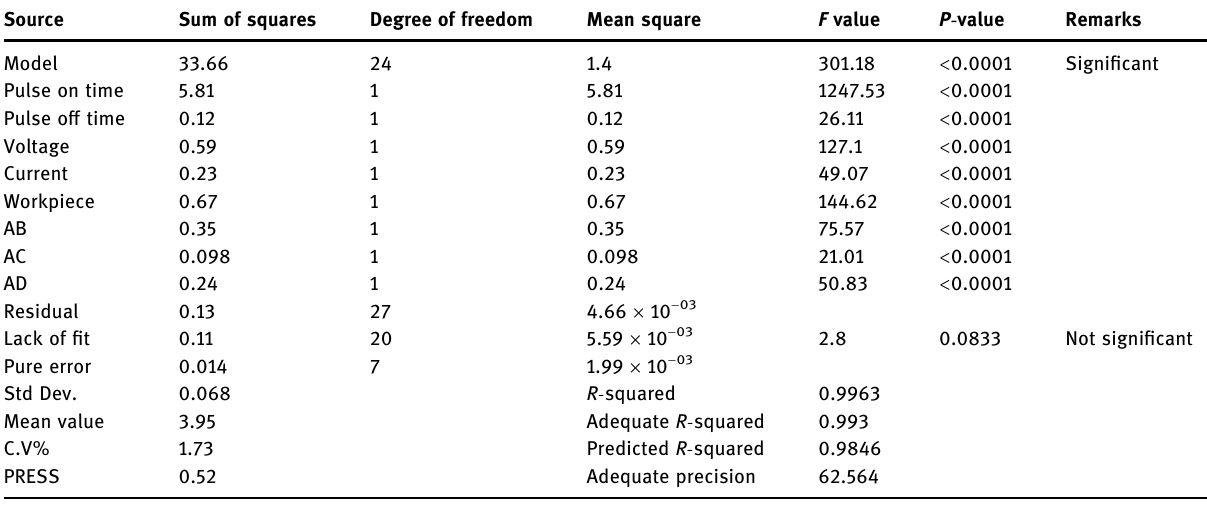
Table 5: ANOVA for response surface of SR Source Sum of squares Degree of freedom